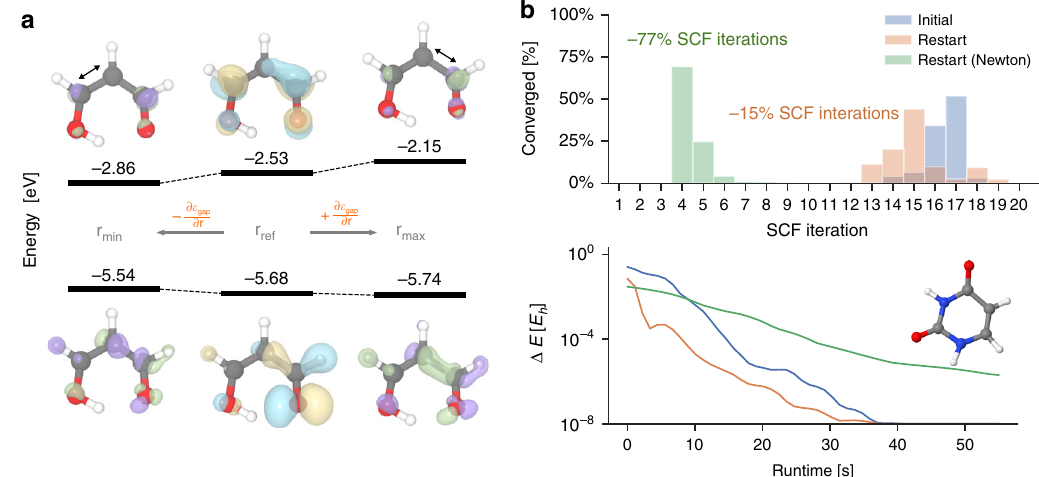
Fig. 4 Applications of SchNOrb. a Optimisation of the HOMO-LUMO gap. HOMO and LUMO with energy levels are shown for a randomly drawn con fi guration of the malonaldehyde dataset (centre) as well as for con fi gurations that were obtained from minimising or maximising the HOMO-LUMO gap prediction using SchNOrb (left and right, respectively). For the optimised con fi gurations, the difference of the orbitals are shown in green (increase) and violet (decrease). The dominant geometrical change is indicated by the black arrows. b The predicted MO coef fi cients for the uracil con fi gurations from the test set are used as a wavefunction guess to obtain accurate solutions from DFT at a reduced number of self-consistent- fi eld (SCF) iterations. This reduces the required SCF iterations by an average of 77% using a Newton solver. In terms of runtime, it is more ef fi cient to use SOSCF, even though this saves only 15% of iterations for